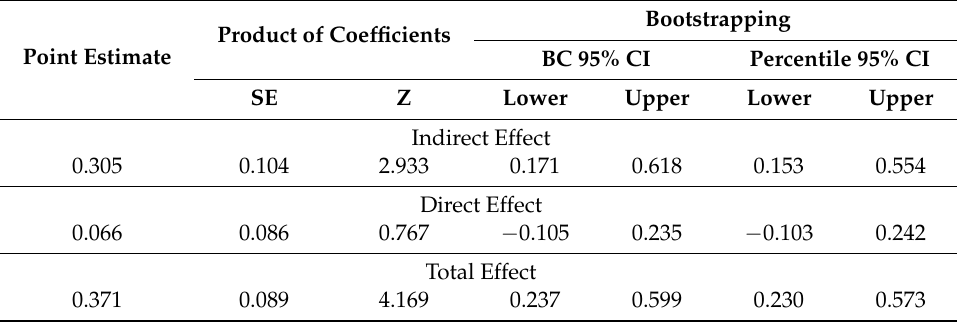
Table 11. Test table of the mediation effect between AOR and ACC.